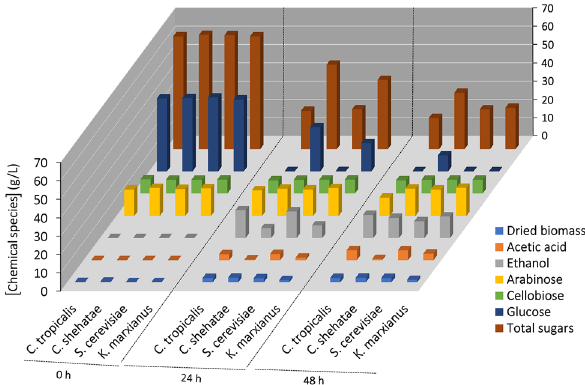
Figure 2. Kinetic profiles of total sugars, individual sugars (cellobiose, glucose and xylose), ethanol, acetic acid and dried biomass concentration levels during cultivation of different yeasts namely C. tropicalis TISTR 5306, C. shehatae TISTR 5843, S. cerevisiae TISTR 5606 and K. marxianus var. marxianus TISTR 5057 with rice straw as substrate. The standard errors in all cases were either within the sensitivity limit of detection procedures or less than